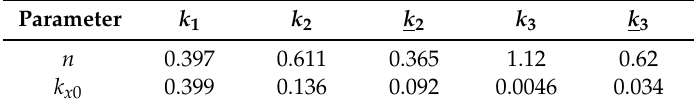
Table 5. Values of k x 0 constants for p 0H